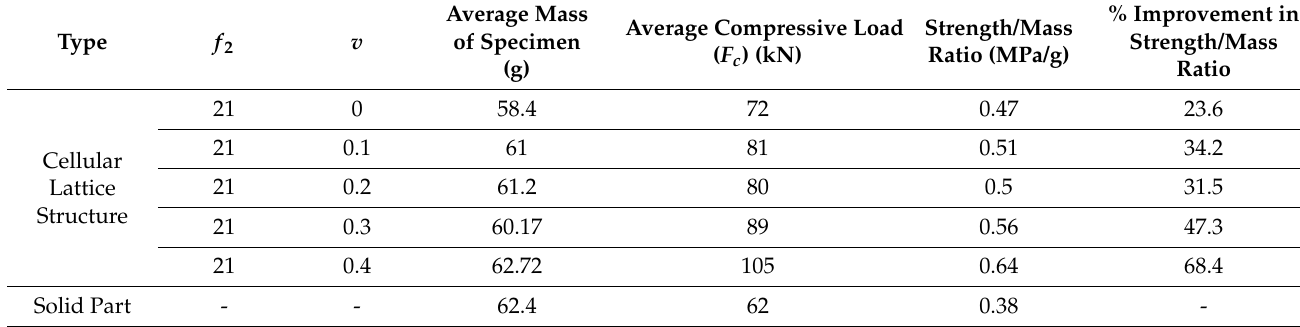
Table 9. Second test series results of test specimens with frequency 21 and 70% infill density.